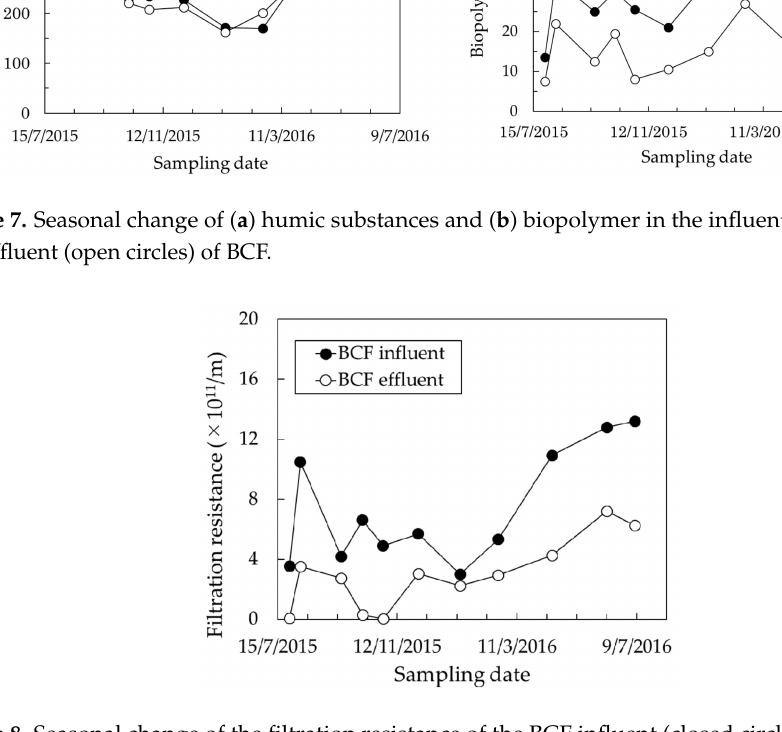
Figure 8. Seasonal change of the filtration resistance of the BCF influent (closed circles) and effluent (open